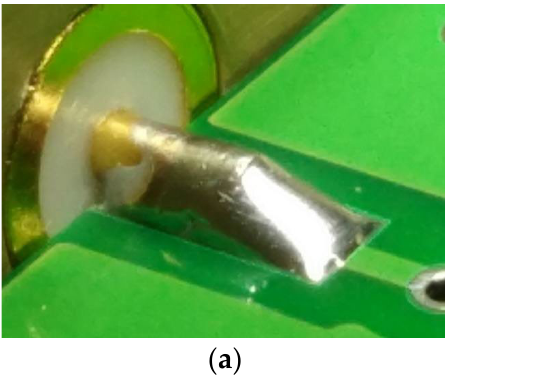
Figure 2. Photos of cracks in directly soldered structure. Three-dimensional electromagnetic simulation and mechanical analysis of the tran- sition structure were carried out according to the actual design. The microwave trans- mission characteristics and the solder joint stresses were simulated. The basic structure can be abstracted as two uniform rods fixed together, one of which is fixed at only one end. The stress can be estimated according to the thermal expansion coefficient, elastic modulus, cross-section area, and the temperature change of each material. Because the actual structure is relatively complex, a simulation method was adopted. By establishing the same 3D model as the real structure, and giving mechanical parameters such as thermal expansion coefficient, tensile strength, and Young’s modulus to each part of the structure as Table 1, the mechanical simulation analysis was carried out after the finite element grid was divided and the connection relationship was set. Taking the seal ap- plied in an aerospace microwave package as an example, the dielectric diameter as D was 1.6 mm, and the inner core diameter as d was 0.3 mm. The materials used for packaging and interconnection structures are as follows: Table 1. Physical parameters of materials. Items